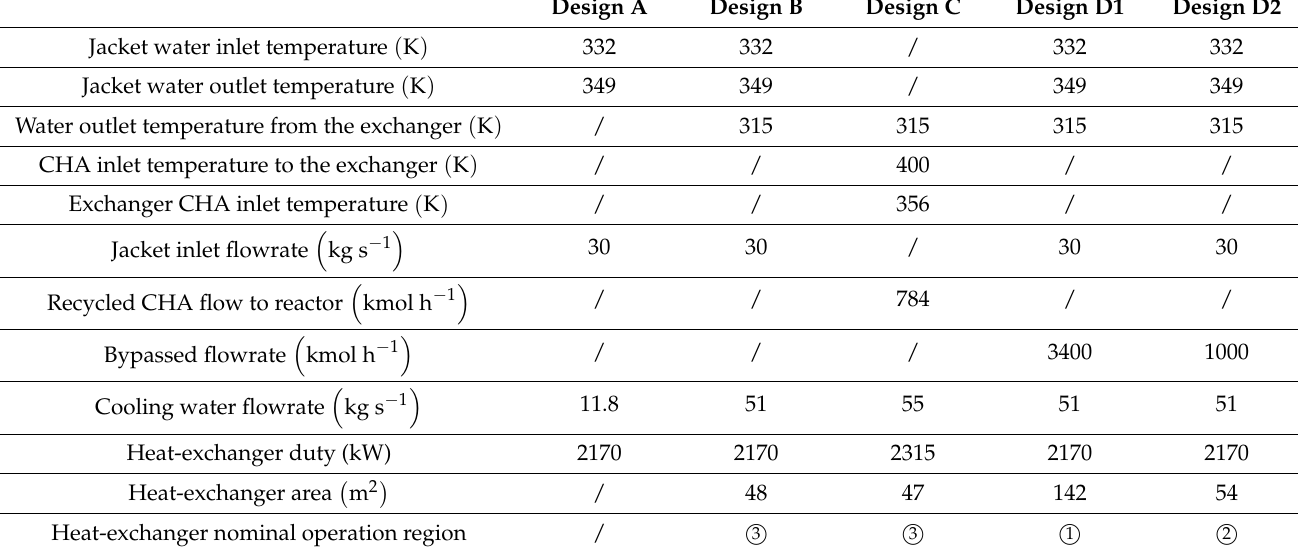
Table 2. Summary of the main characteristics of the proposed plant